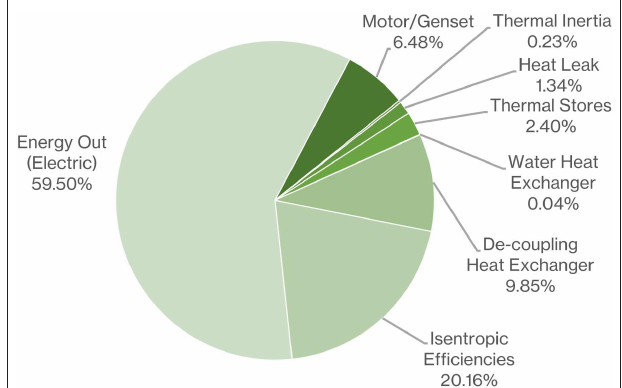
FIGURE 27 | Inventory of losses for each sub-system of the coupled 1 GWh PTES system.